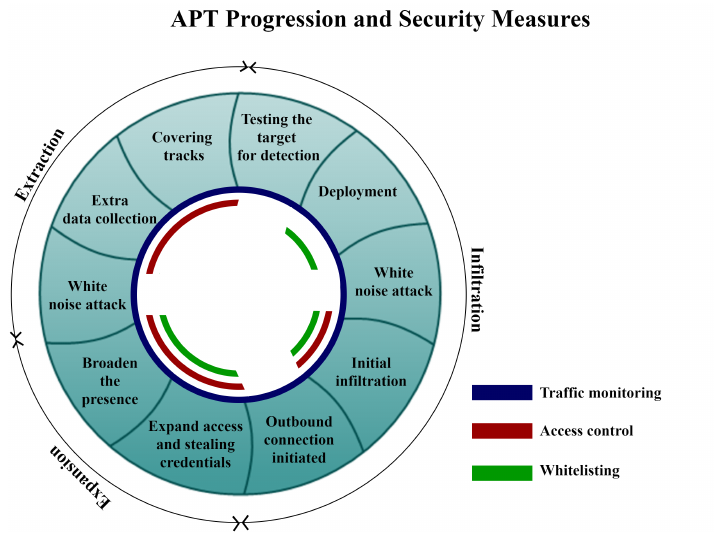
Figure 5. The anatomy of an APT